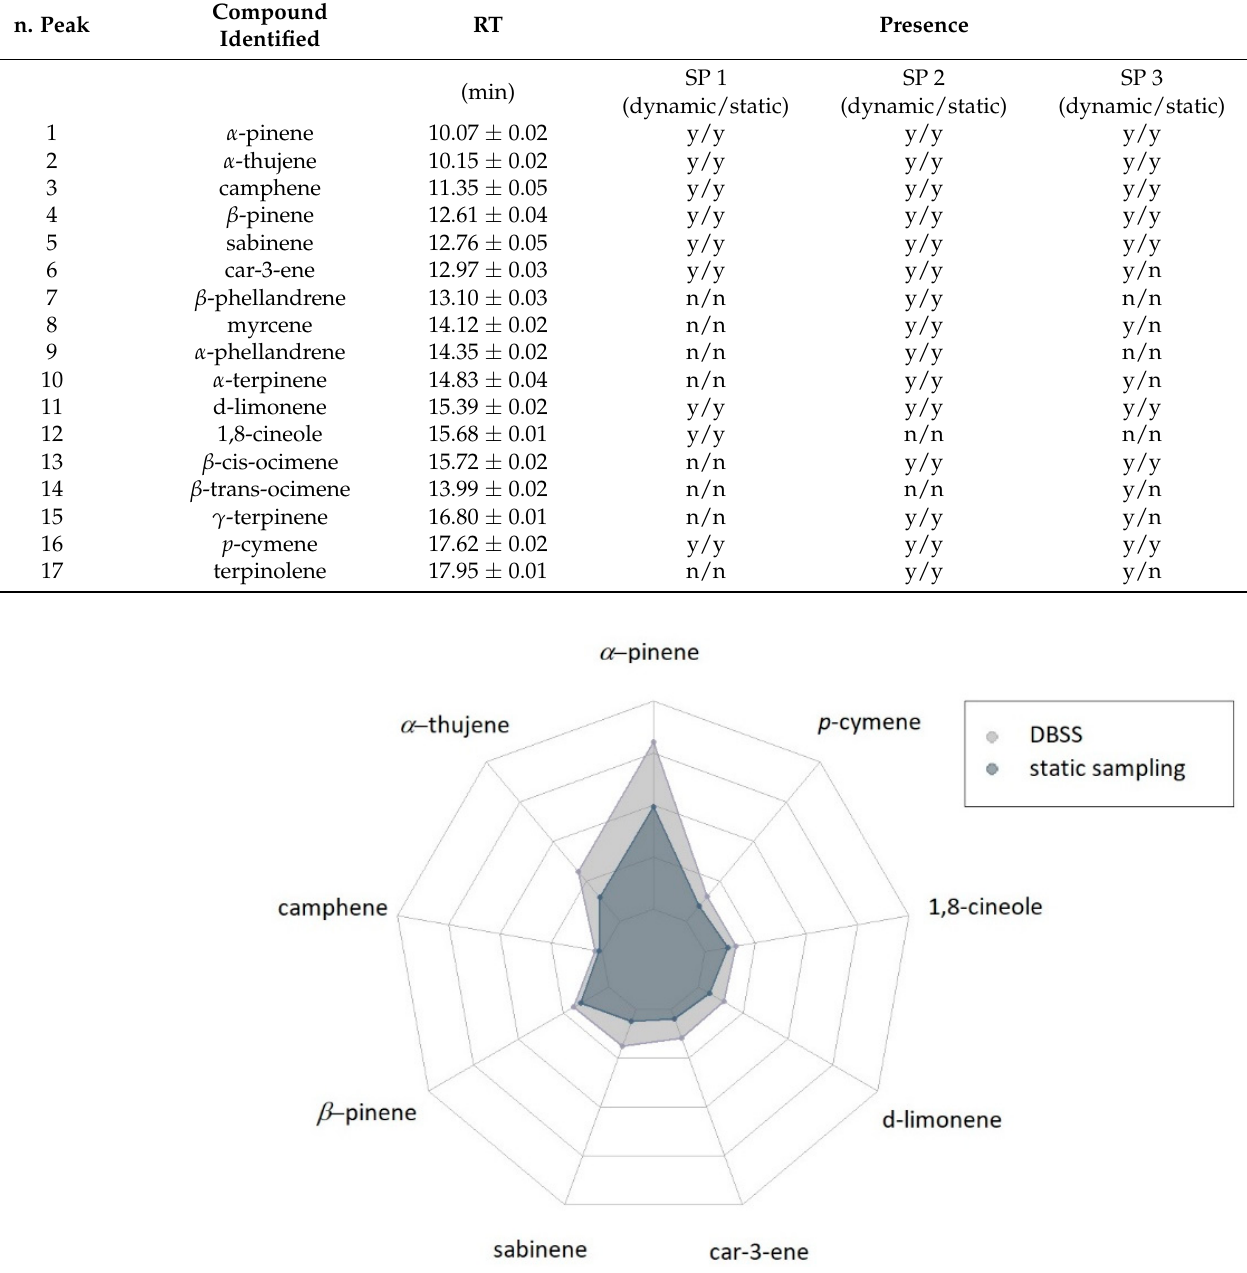
Figure 1. Radar-plot showing the results of the semi-quantitative analysis of BVOCs at sampling point 1 ( n = 3) expressed as the peak area of each individual compound. The amounts of different compounds range between 0 and 350,000. Results of statistical analysis are reported in Table